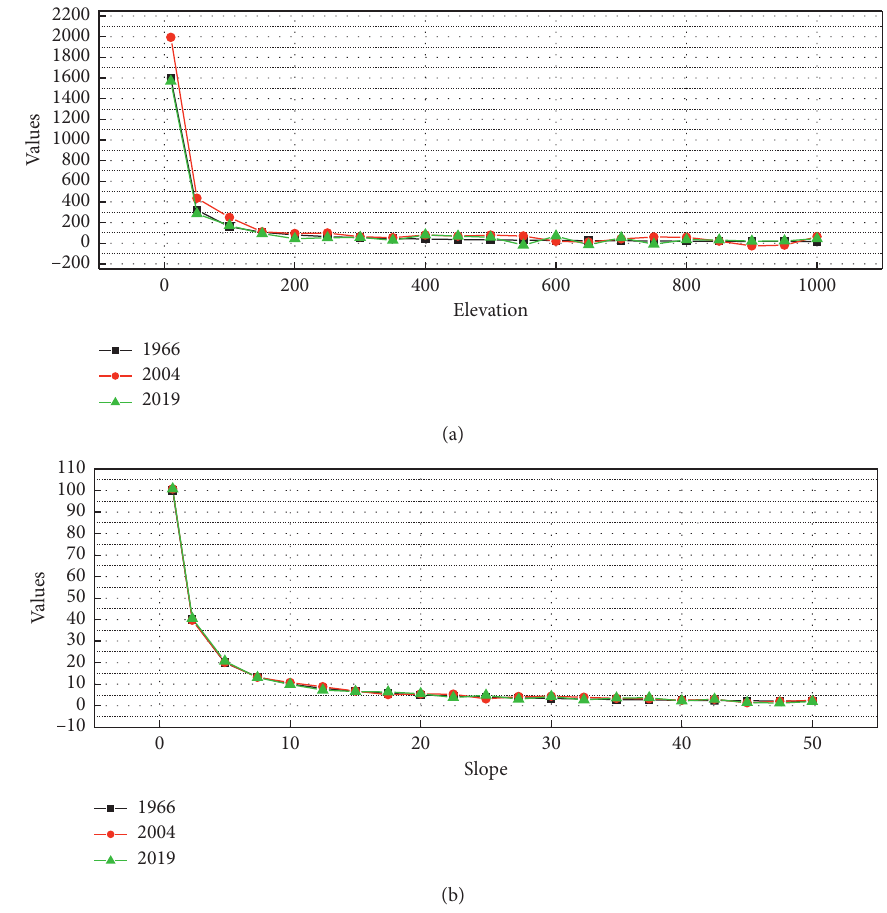
Figure 3: City size variation with elevation and slope.